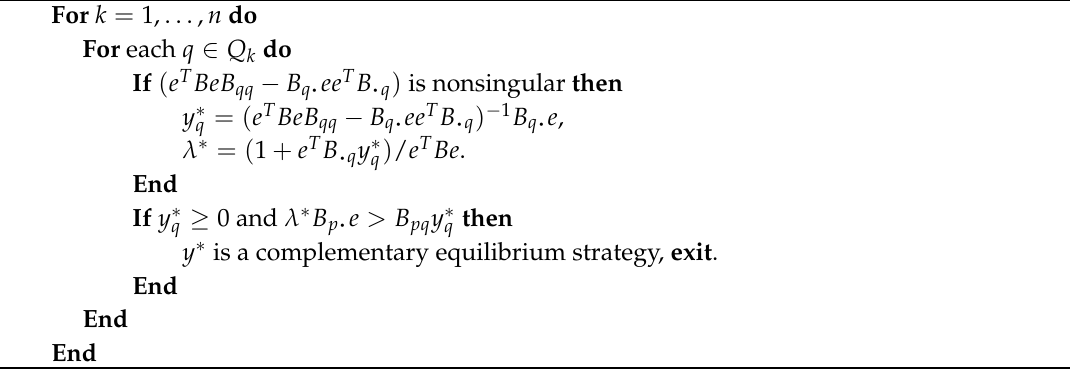
Algorithm 5: A Sparse Complementary Shapley-Snow Algorithm